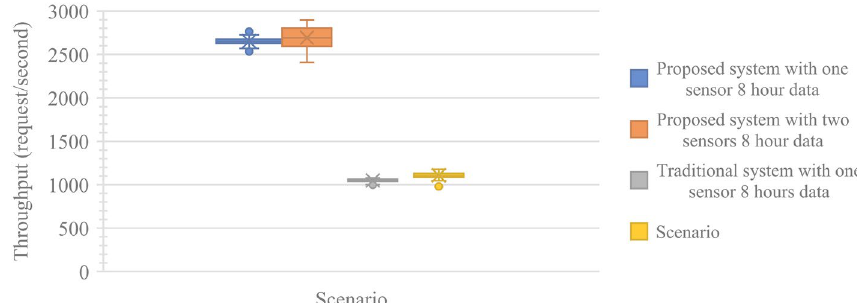
Fig. 8 Cumulative distribution chart of throughput evaluation